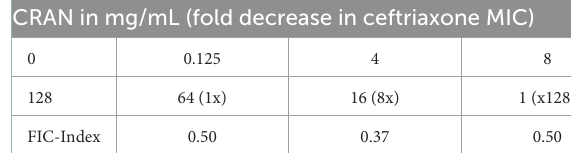
exposure. As expected, exposure to < 1/8 MIC AXO (4 µ g/mL) TABLE 2 Minimal inhibitory concentration (MIC) of ceftriaxone ( µ g/mL) in the presence of an increasing concentration of the cranberry extract (CRAN) in